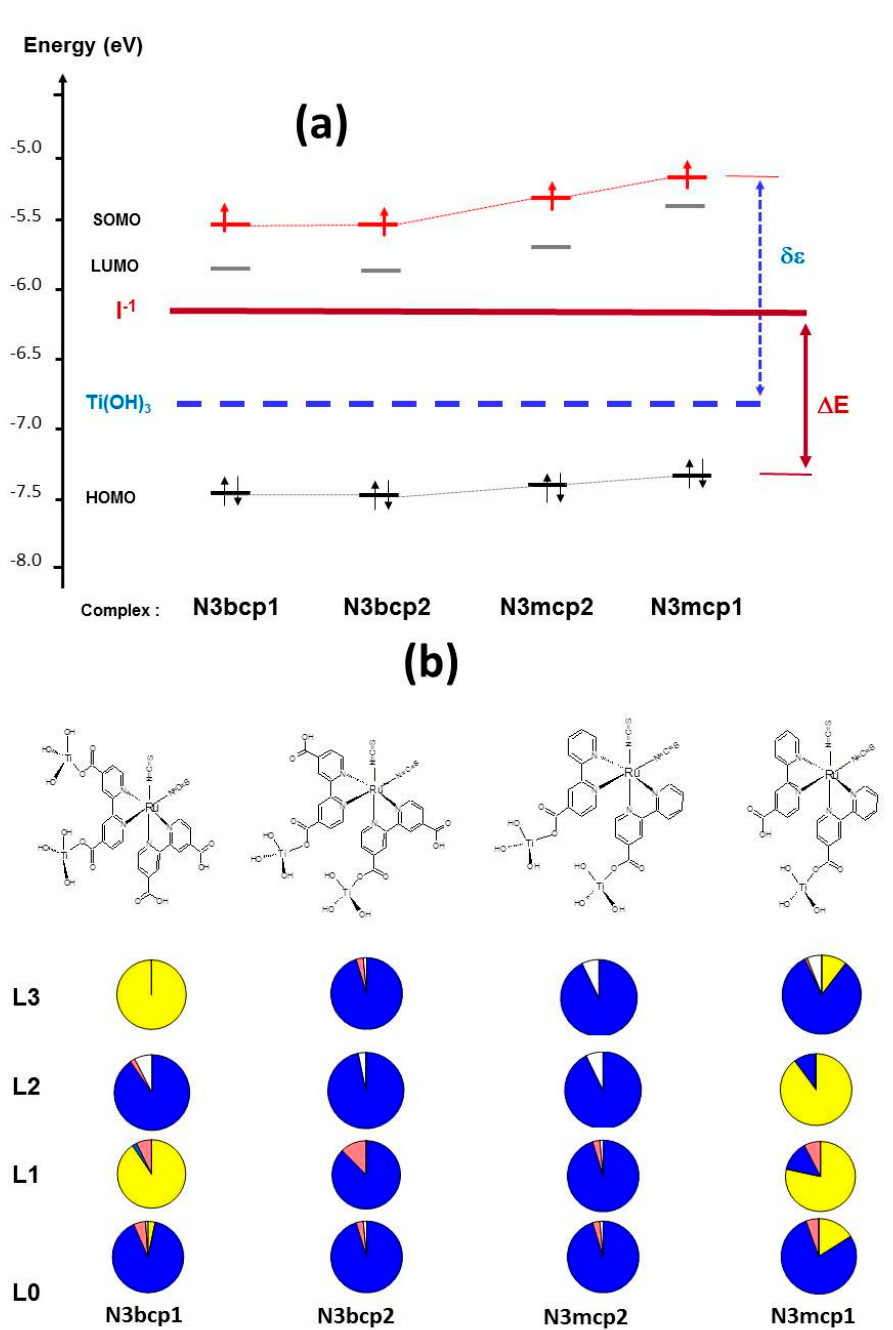
Figure 38. ( a ) Molecular orbital energies scheme. ( b ) Transition density analysis (yellow: ancillary ligand, blue: anchor ligand, pink: ruthenium, white: acceptor).